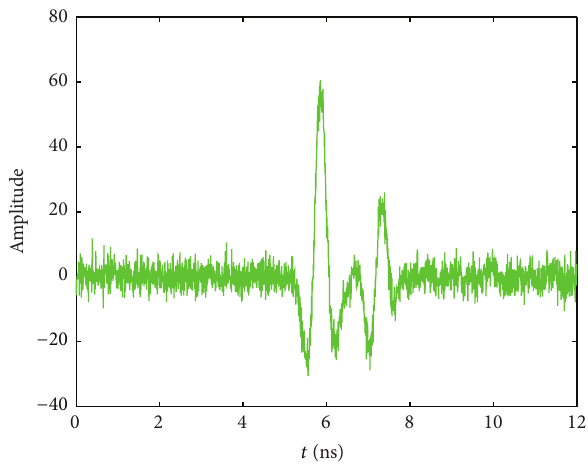
Figure 4: Figure 2(a) after mean filtering.